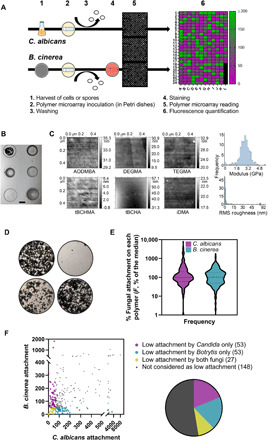
Polymer microarray screening for fungal attachment.(A) Fungal attachment assay procedure for C. albicans and B. cinerea, detected by yCherry expression or Congo red staining, respectively. (B) Microscopic image of a representative area encompassing six polymer spots on a polymer microarray slide. Scale bar, 150 μm. (C) Representative AFM height images of polymer microarray spots for six selected polymers (lead materials for C. albicans; see later) and histograms of modulus (dry) and roughness across all array polymers. AODMBA, (R)-α-acryloyloxy-β,β-dimethyl-γ-butyrolactone; TEGMA, tri(ethylene glycol) methyl ether methacrylate; tBCHMA, tert-butylcyclohexyl methacrylate; (D) Microscopic images of B. cinerea spore adhesion on glass (top left) and three representative microarray polymers with differing attachment properties. Top right: Polymer of interest. Polymer spots are ~300 μm in diameter. (E) Distribution of fungal attachment results across the polymer arrays. Attachment percentages are relative to the median (equal to 100%) for each fungus. Values are means from six (C. albicans) or three (B. cinerea) independent replicates. The full data and polymer names are listed in table S1. (F) Comparison of % attachment (relative to median) by B. cinerea and C. albicans to the different polymers. R2 = 0.097; P < 0.0001.